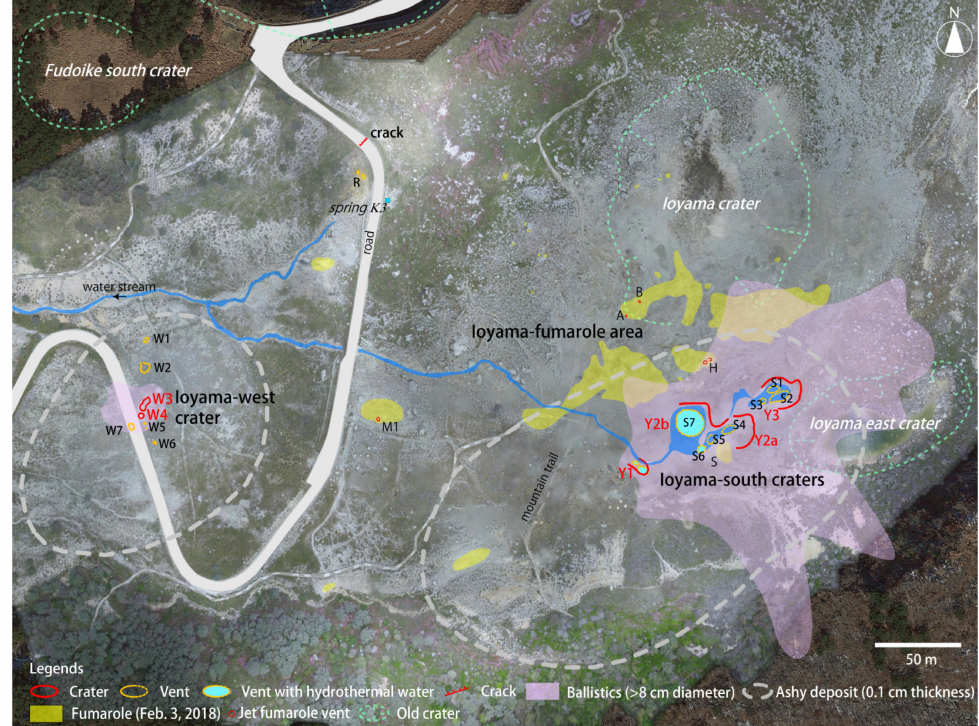
Figure 3. Drone image showing the distribution of geothermal features, ejecta and craters formed during the April 2018 eruption. Yellow areas: fumaroles, as observed on 3 February 2018 and jet fumarole vents (thin red circles). Orange circles: Eruption and hydrothermal vents appeared as Y1 (7 April 2018), S1 to S7 (19 to 20 April 2018) and W1 to W7 (20 to 21 April 2018). The distribution of ballistics is shown for over ϕ 8 cm. Gray dash lined: ashy deposit with a thickness of 0.1 cm. Bold red lines and texts: eruption craters Y2a, Y2b, Y3, Y1, W3 and W4. Blue areas: hydrothermal ponds and streams. R is a mud pot that appeared after the eruption. The red line on the road is a